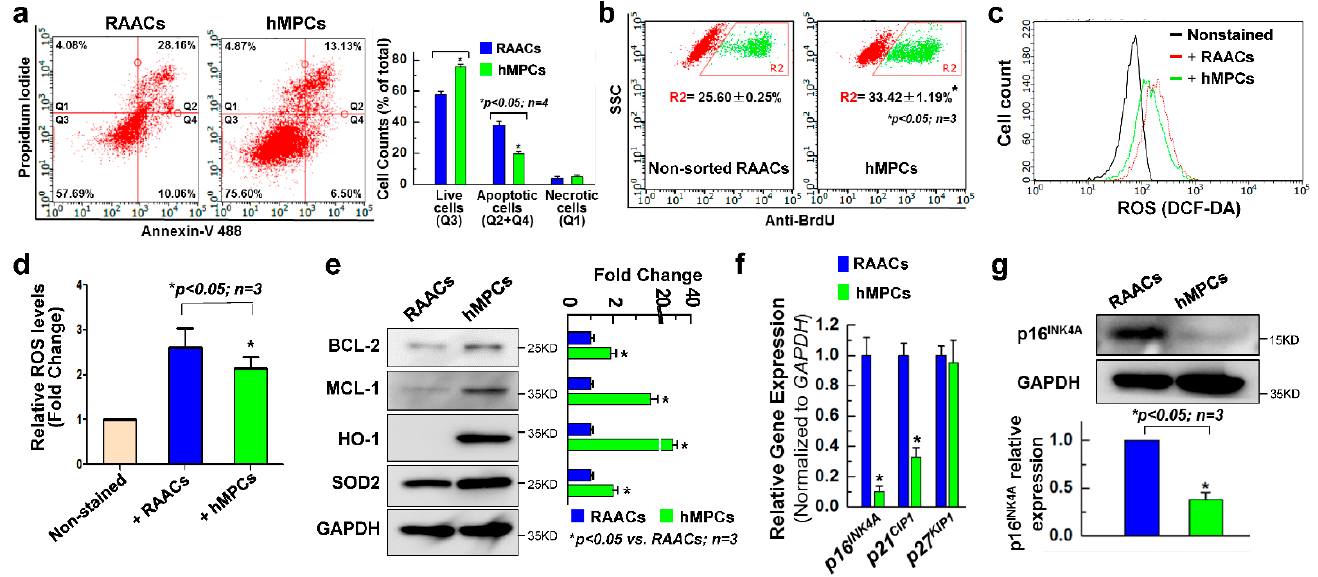
Figure 2. The hMPCs exhibit better reparative capacity. ( a ) Apoptotic assay with the double staining of Annexin V and propidium iodide (PI) in hMPCs and RAACs following the oxidative stress induced by H 2 O 2 . ( b ) FACS analysis for the proliferation assay following the incorporation and staining with BrdU in hMPCs and RAACs. ( c ) Reactive oxygen species (ROS) measurements for hMPCs and RAACs after staining with 2 ′ ,7 ′ -dichlorofluorescin diacetate (DCF-DA) dye. ( d ) Quantitative analysis of ROS levels in hMPCs and RAACs as shown in ( c ). The y-axis represents the relative fold changes of ROS levels. ( e ) Western blots for the expression anti-apoptotic proteins (BCL-2 and MCL-1) and anti-oxidative proteins (HO-1 and SOD2) in hMPCs and RAACs. ( f ) Quantitative PCR analysis of the mRNA expression of senescence marker genes (p16 INk4a , p21 CIP1 , and p27 KIP1 ) in hMPCs and RAACs. The y-axis represents the relative mRNA expression of target genes normalized to GAPDH. ( g ) Western blots confirmed the lower protein expression of senescence marker p16 INK4a in hMPCs versus RAACs. Data are means ± SEM. Note: * p < 0.05, unpaired Student’s t -test, n ≥ 3 independent